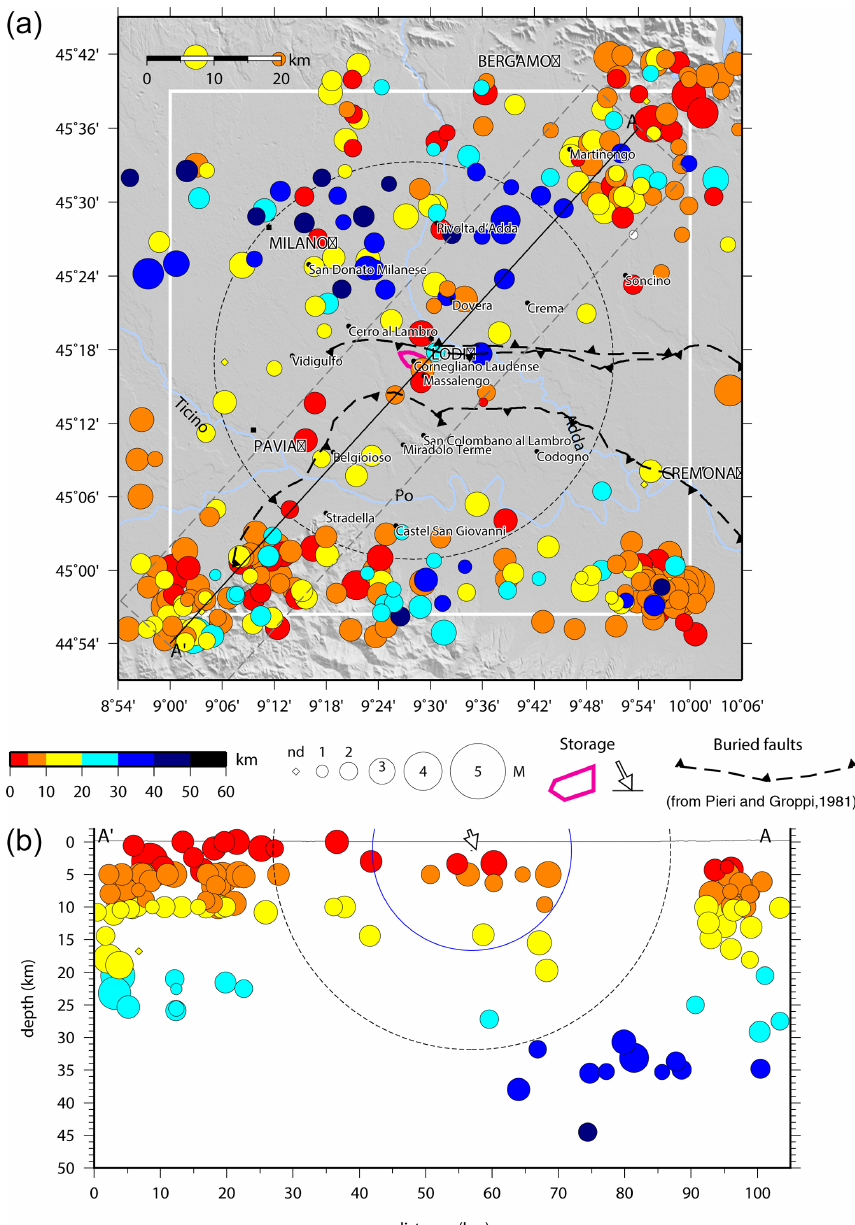
Figure 5. Composite earthquake catalogue for the study area from 1980 to 2019: (a) epicentral map of events that approximately fall in the target area (latitude 44.94–45.65 ◦ N; longitude 9.00–10.00 ◦ E, white frame); (b) vertical cross section AA’. The 15 and 30km distances from the reservoir (ED and OD domains) are marked by blue and black dashed circles, respectively; in the magnitude scale, nd means not defined; the reservoir is indicated by the pink polygon (map) and the arrow (section). The main buried faults are taken from Pieri and Groppi,